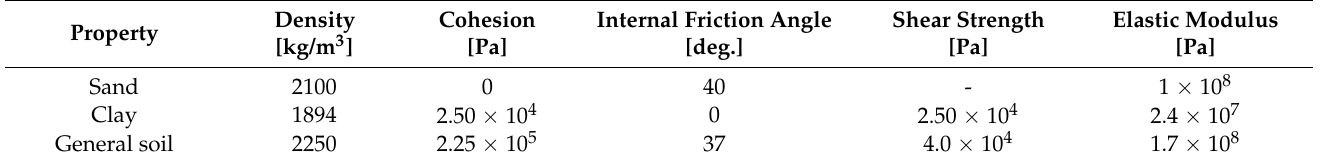
Table 1. Material properties of